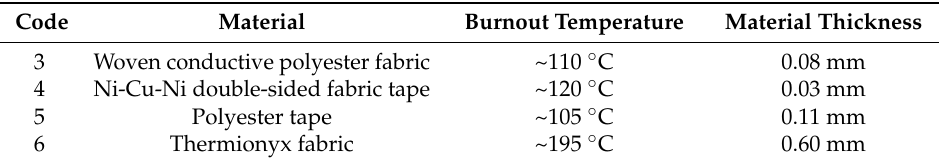
Table 6. Burnout Temperature of Conductive